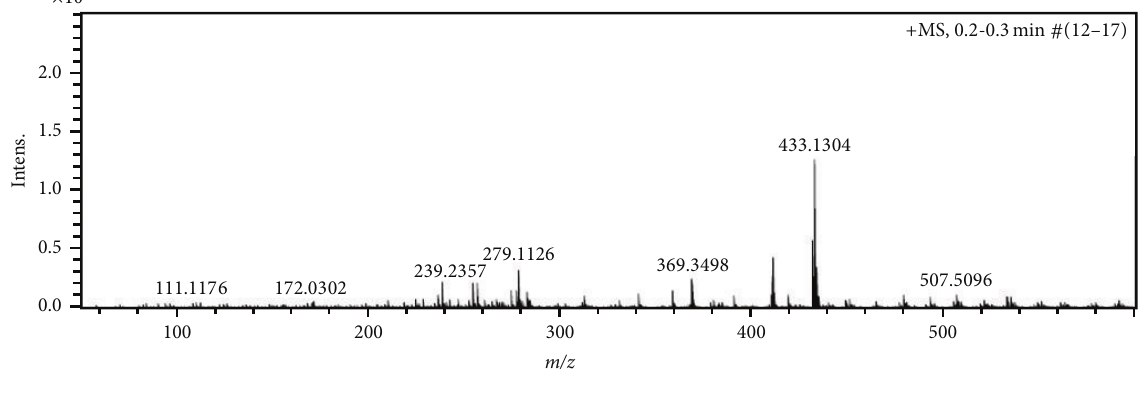
Figure 5: Mass spectrum of Bmpp-Sn ( 2 ).